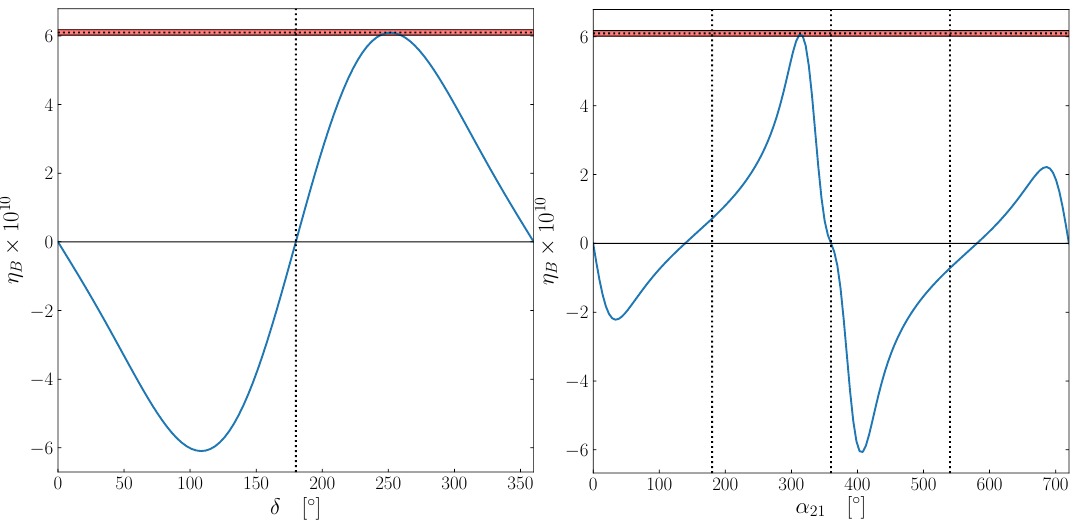
Figure 5 . The baryon asymmetry as a function of one of the CPV phases of the PMNS matrix (cid:14) , (cid:11) 21 and (cid:11) 31 (the other two being set to zero), with the varied phase providing all the CP violation in leptogenesis, in the case of neutrino mass spectrum with normal ordering. Vertical dotted lines represent values for which there is a complete CP symmetry in the neutrino sector. See text for further details.